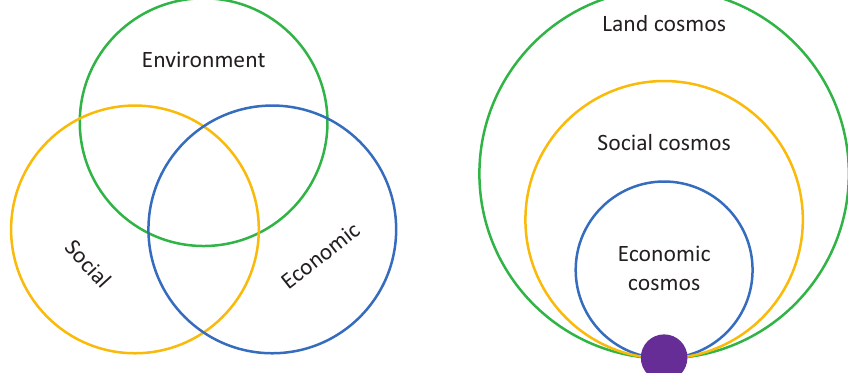
Figure 4. From a sectoral model of sustainable development (left) to an integrated one (right). Source: Authors’ work, adapted from Mebratu